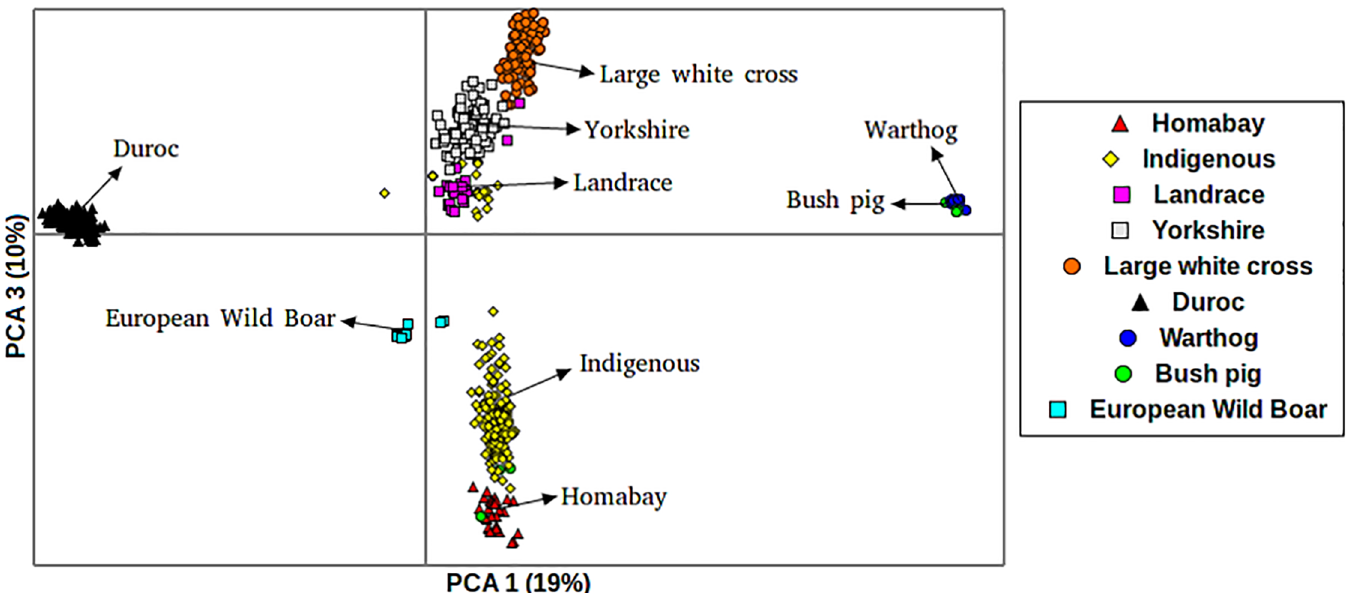
Fig 2. PCA plot for pigs indicating their distribution along the first and third eigenvectors. https://doi.org/10.1371/journal.pone.0190080.g002 and Large White breeds become distinct clusters within the commercial pig group. The results indicate that the Busia pig population consists of non-homogenous admixed pigs with an average commercial pig genetic composition of 10% (± 0.7% SE) and ranging from 0 to 28%. The Homabay domestic pigs displayed no trace of either wild or commercial pig introgression. Based on the cross-validation test, K = 5, seems to best describe the popula- tion Fig 4.